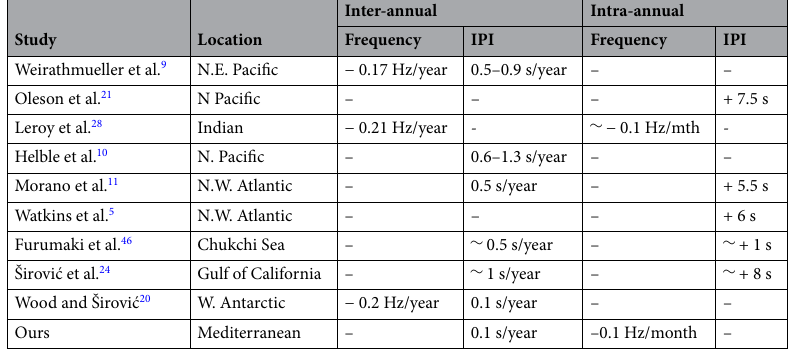
Table 2. Summary of fin whale song trends studies. For intra-annual IPI shifts, since trends are not linear, we report the difference between low IPI season and high IPI season (summer vs winter). Note that the inter- annual IPI shift of Morano et al. 11 is reported between two consecutive years only, and the frequency shifts of Leroy et al. 28 are for the 99 Hz pulse rather than the 20 Hz